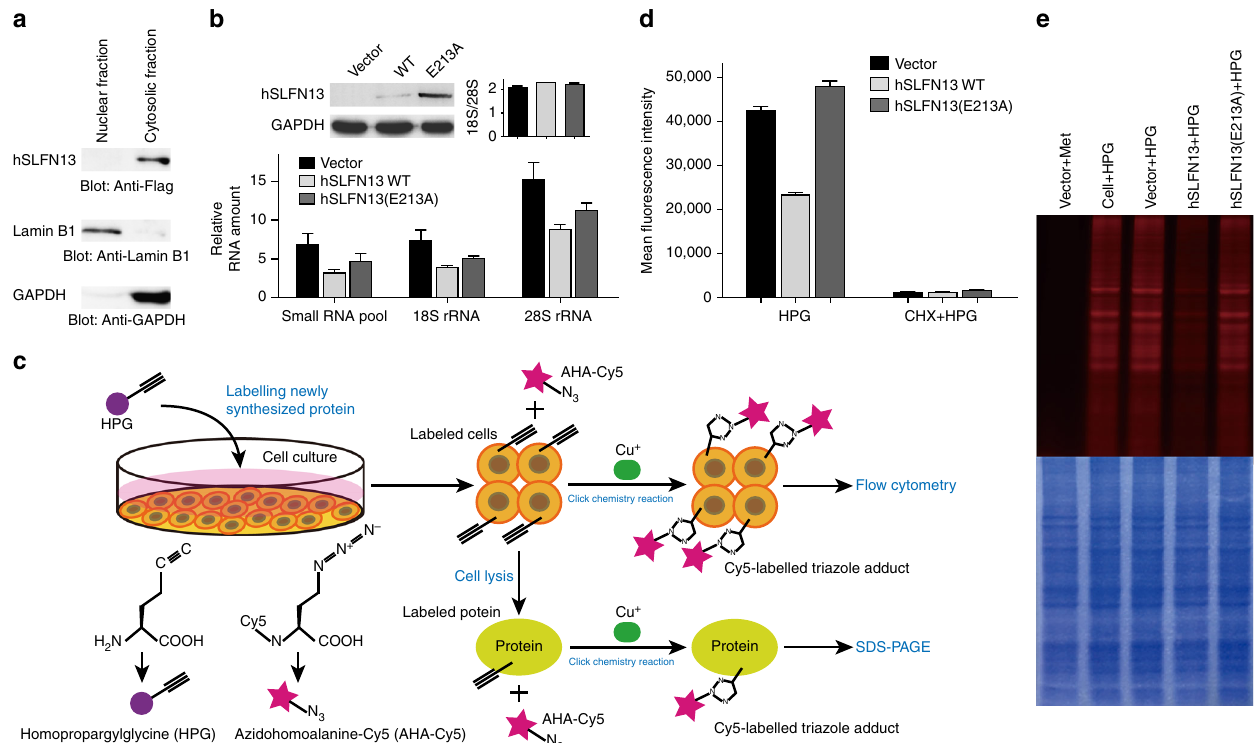
Fig. 5 hSLFN13 disrupts translational machinery. a Subcellular localisation of hSLFN13. b hSLFN13 restricts tRNAs and rRNAs in cells. The small RNA pool is mainly constituted of tRNAs and 5S/5.8S rRNA (See Supplementary Fig. 8f). Expression of hSLFN13 WT and hSLFN13(E213A) was con fi rmed by Western blot. Note the prominent restriction of cellular RNAs caused by relatively low level of overexpressed hSLFN13. Error bar indicates s.d. ( n = 3). c The experimental process of the FUNCAT-click chemistry assay. d FUNCAT assay and subsequent fl ow cytometry examination for Cy5 fl uorescence showing that hSLFN13 inhibits protein synthesis in living cells. e hSLFN13 inhibits protein synthesis. Upper: fl uorescent image of the SDS-PAGE gel showing the newly synthesised proteins labelled by FUNCAT assay. Lower: same gel stained with Coomassie Blue showing the loading